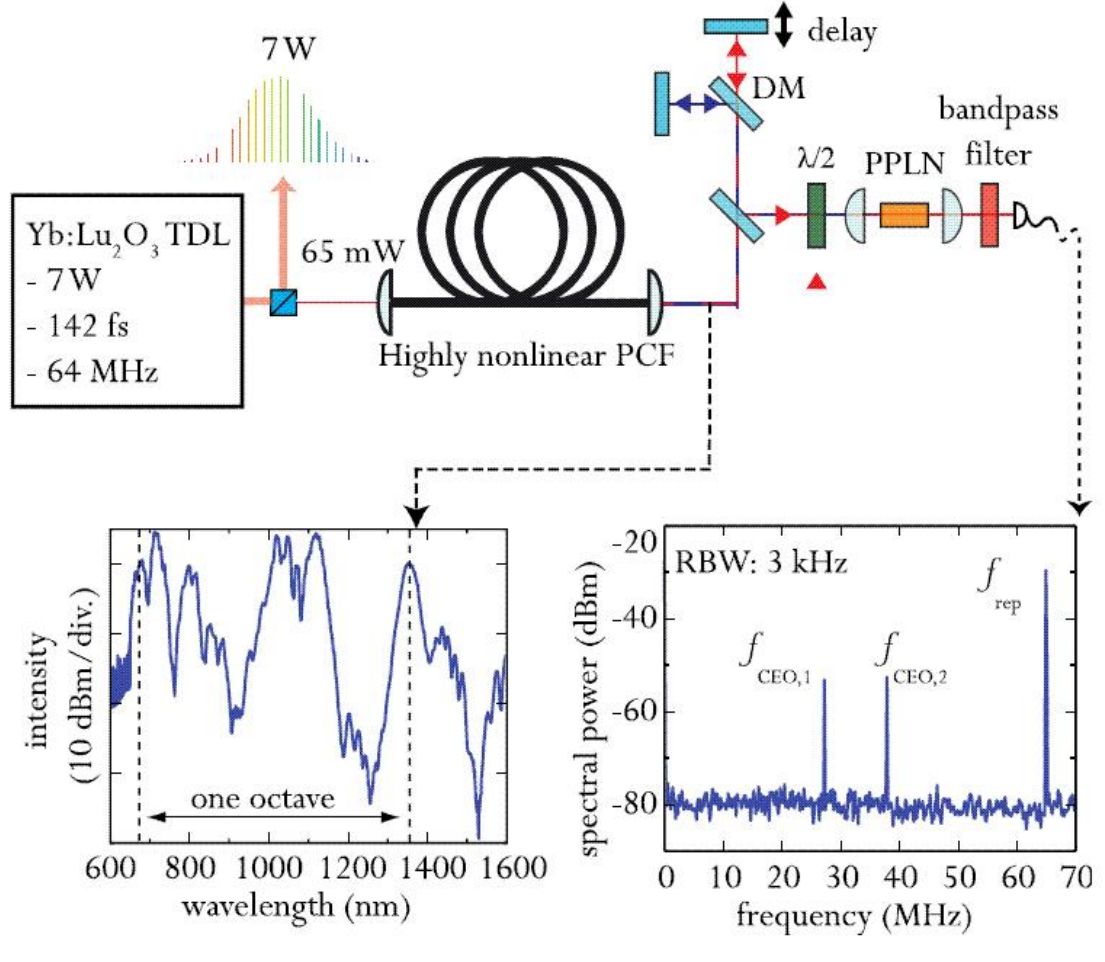
Figure 18. Setup for carrier-envelope offset (CEO) frequency detection of Yb:LuO modelocked